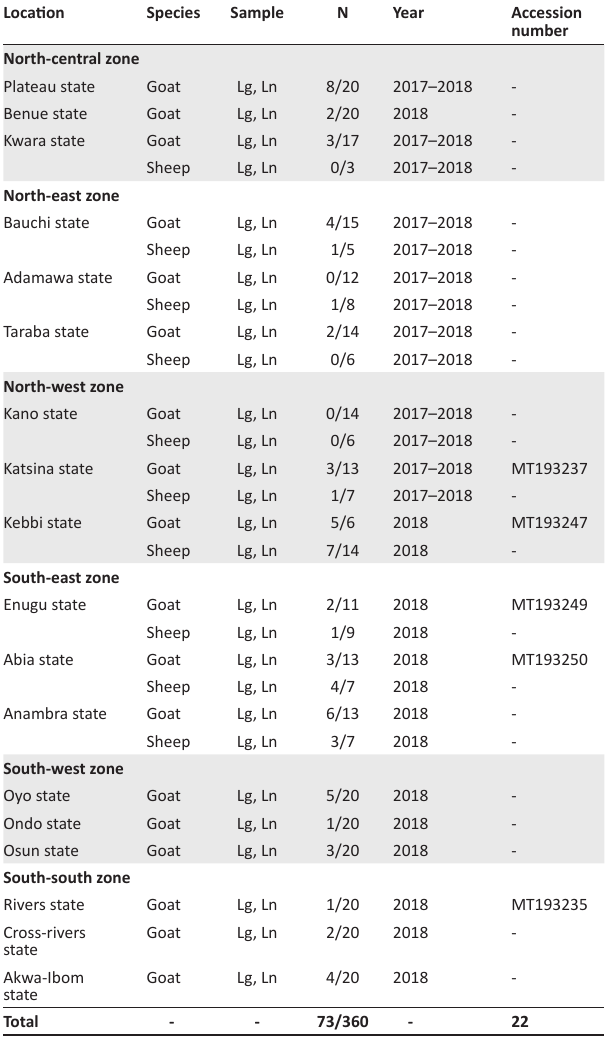
TABLE 1: List of Peste des petits ruminants viruses-positive samples and partial N gene sequences obtained during this study. Location Species